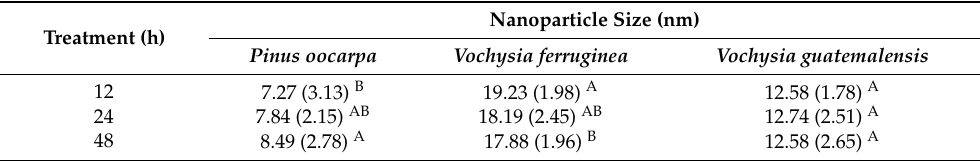
Table 2. Particle size of Fe 3 O 4 NPs in the magnetic wood with three different immersion times in ammonia in three tropical wood species from fast-growth plantations in Costa Rica.